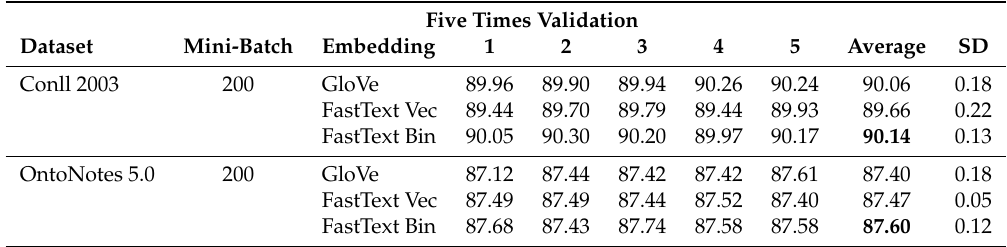
Table A2. Five times F1 scores of the pre-trained word embedding with two-stacked bidirectional LSTM. From the result, we achieve the best F1 score when using FastText with